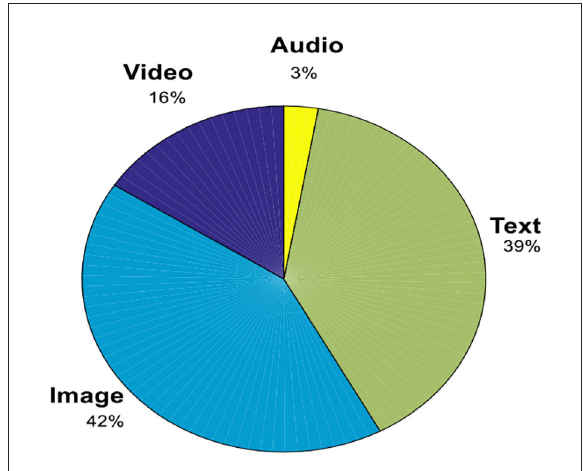
FIGURE5 Percentage of research papers published on the encryption of various multimedia contents like: images, video, audio, text data during